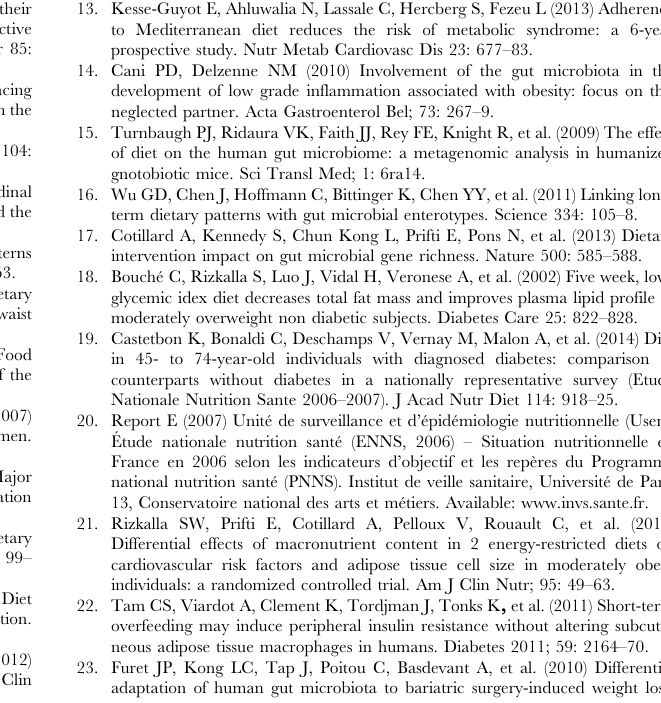
consumers for each food category for lean and overweight and obese subjects. Table S4, Mean daily nutrient intakes for lean, overweight/obese subjects and dietary clusters. Table S5, P values for variance in nutrient intakes between lean subjects and all overweight/obese subjects, and between lean subjects and individual clusters. Table S6, Differences in gut microbiota (qPCR) in lean, overweight/obese subjects and in the 3 dietary clusters. Table S7, P values for variance in gut microbiota (qPCR) between lean subjects and all overweight/obese subjects, and between lean subjects and individual clusters. Table S8, Correlations between the 7 gut bacterial groups measured by the qPCR and the intake of food groups without stratification to clusters. Heatmap of correlations between qPCR data and food categories. Table S9, Differences in gene richness group (LGC/ HGC subjects) in the 3 dietary